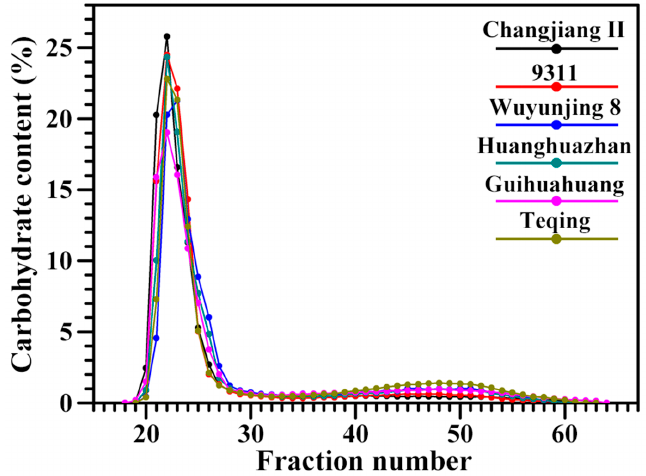
Figure 2. GPC profiles of fully branched starches.